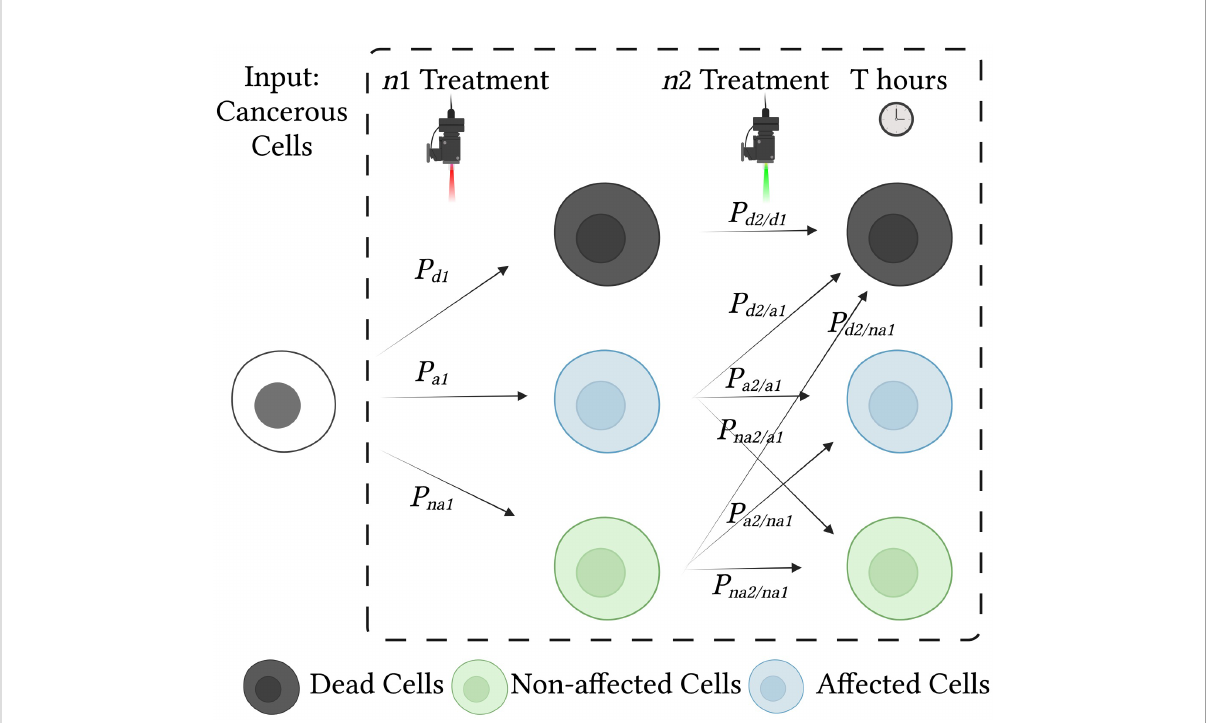
FIGURE 2 Effects of treatment on cells and probabilities of each cell state. Cancerous cells are treated with two consecutive treatments, n 1 and n 2. Each treatment in fl uences the condition of the cells and may result in cell death, cell damage (affected cells), or no change (unaffected cells). To analyze the effect of the combined treatment, we use a state diagram with conditional